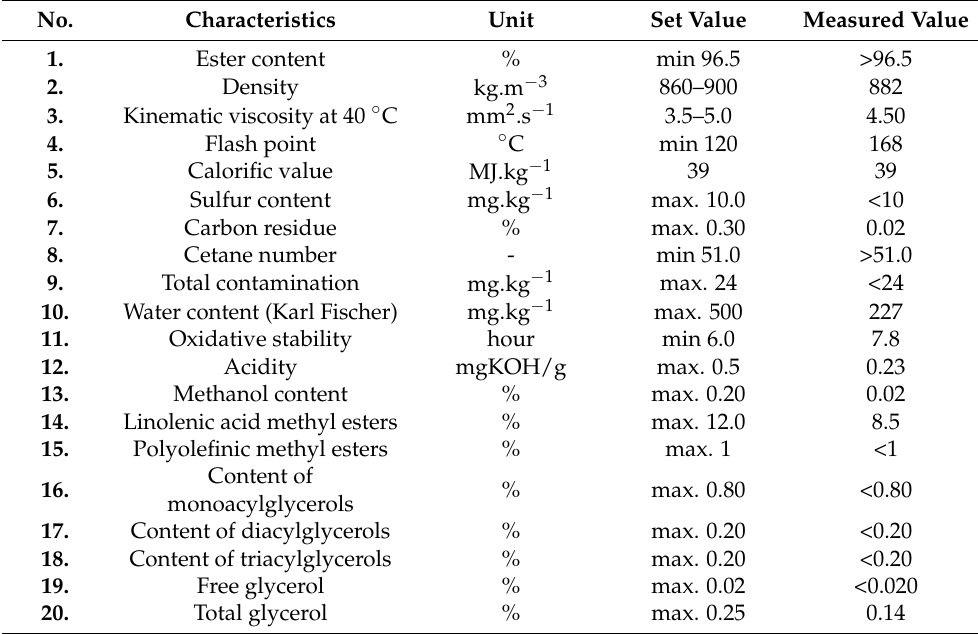
Table 2. Extract from the quality certificate FAME PT—Fatty Acid Methyl Ester for diesel engines manufacturer FUELMA-TUMYS, a.s., analysis number: 50/06 dated 6 September 2006.